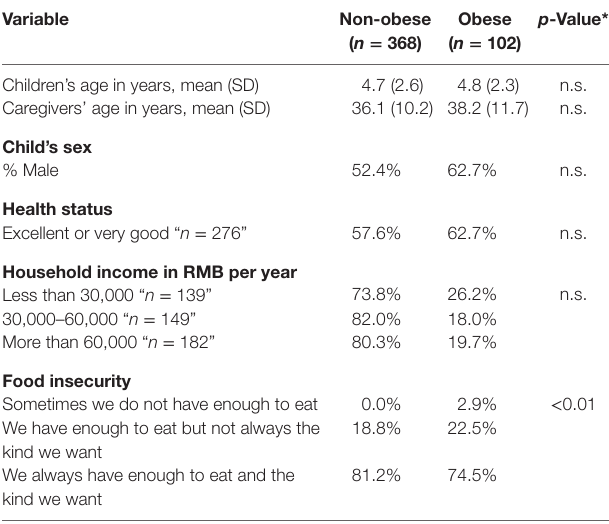
TaBle 1 | Demographic characteristics by children’s obesity